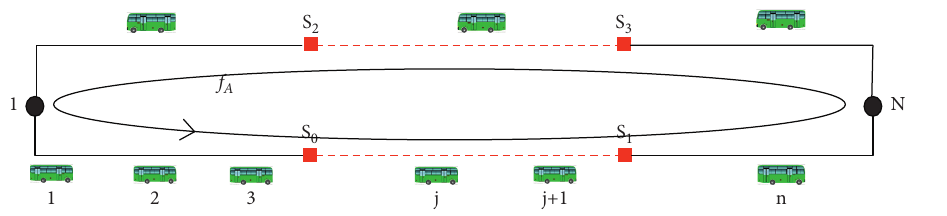
Figure 1: schematic diagram of the full-length bus operation.